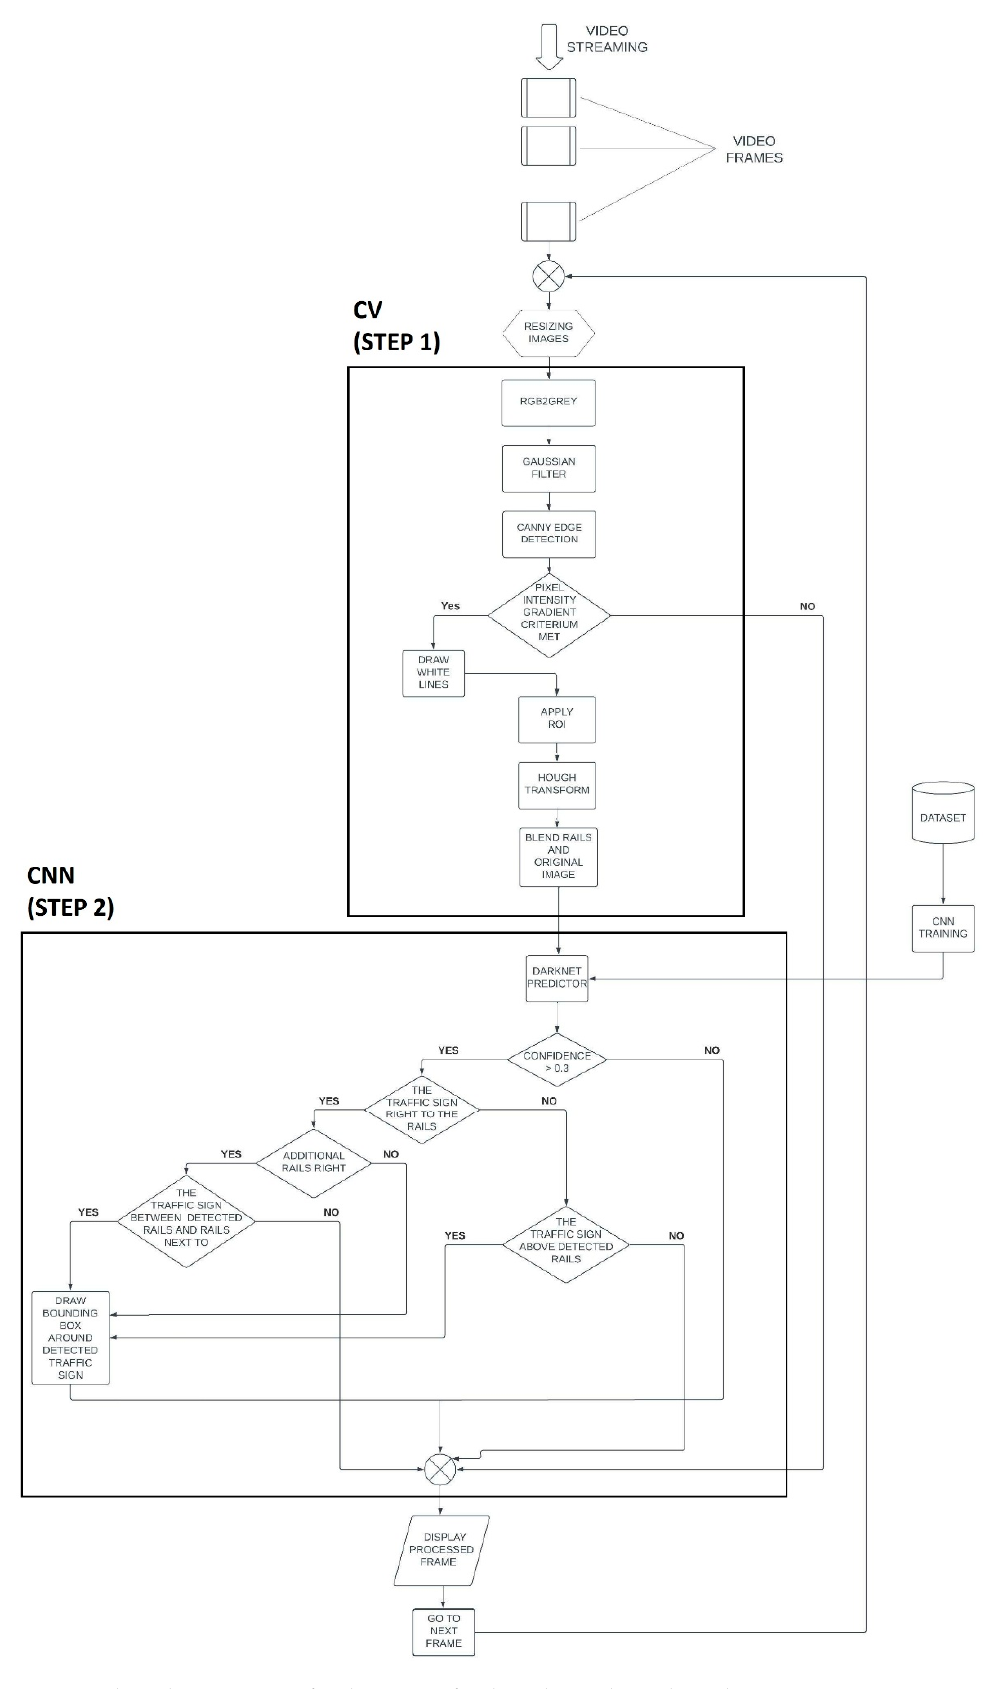
Figure 2. Flow chart—System for detection of rails and signals on the railway.